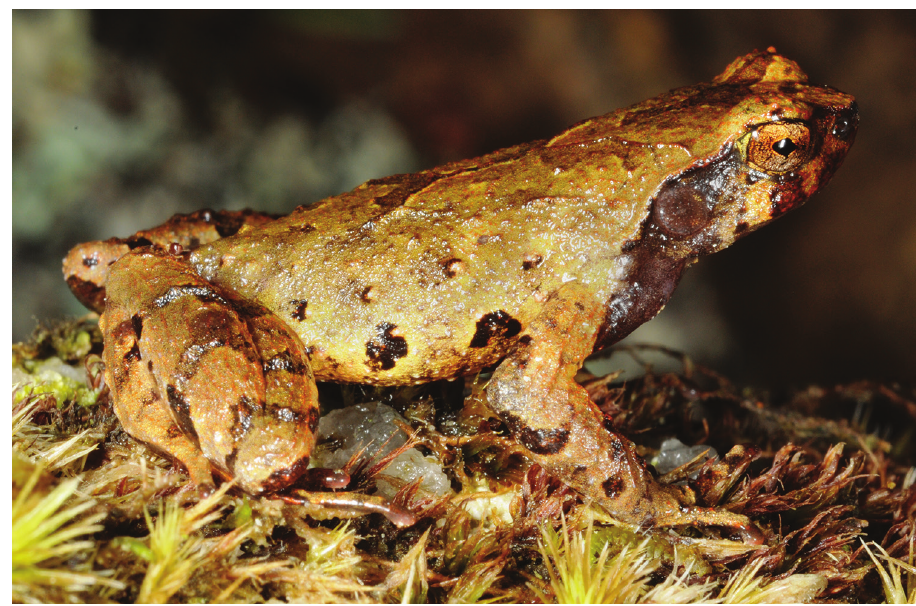
Figure 9. Holotype of Ophryophryne elfina sp. n. in life (ZMMU A-5669, male, field number NAP-02658), dorsolateral view. Photos by N.A.